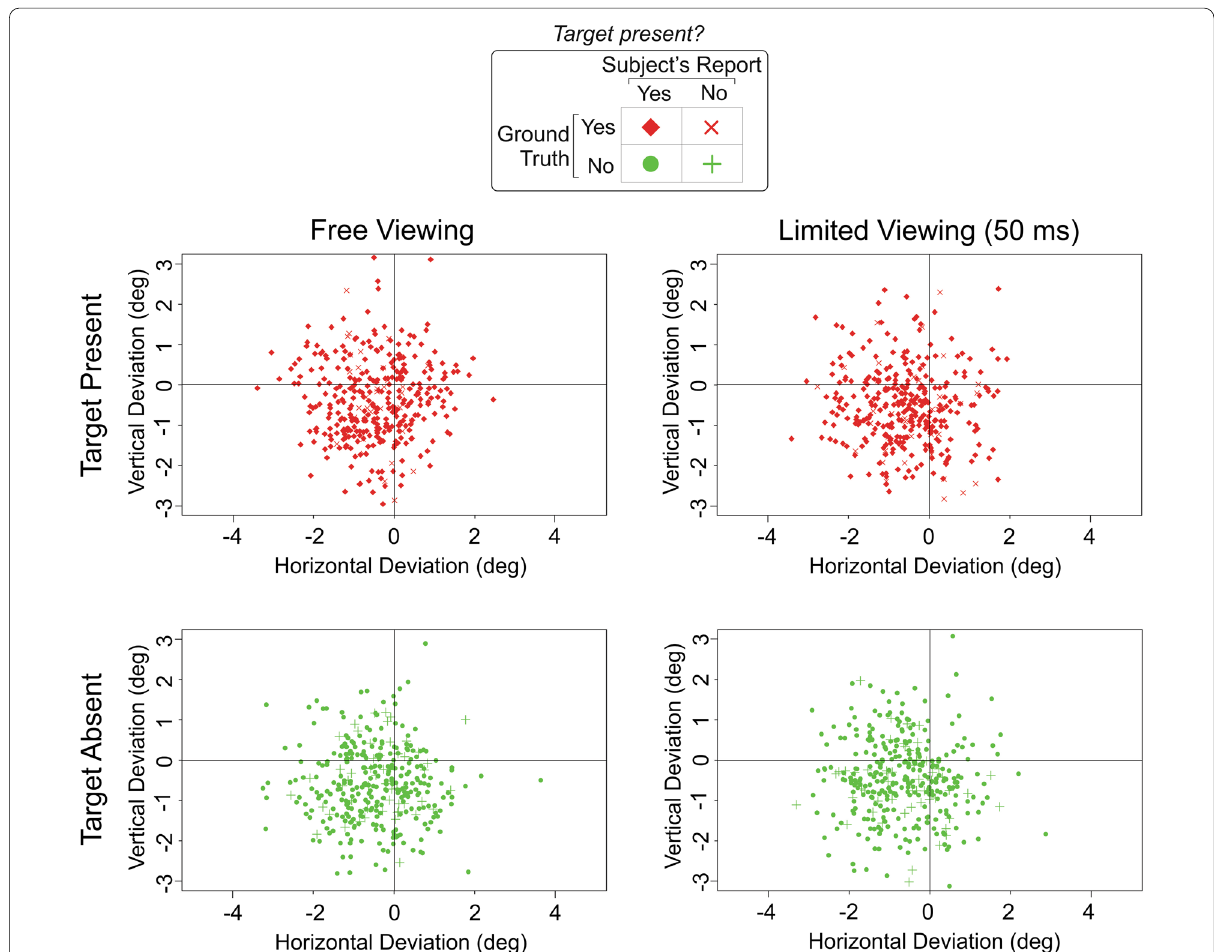
Fig. 2 Localization of camouflage targets in Experiment 1. The scatter plots in the left column show the localization data for free viewing. Scatter plots in the right column show the data for time-limited viewing of 50 ms. Scatterplots in the top and bottom rows show data for stimuli with or without a target, respectively. Scatterplots in the left and right columns show data for stimuli viewed freely or for 50 ms, respectively. Each plotting symbol in each scatterplot denotes the localization data from a single trial (see inset at top center ), plotted as the angular deviation of the reported target location from the actual location, so that the cross-hairs denote perfectly accurate localization. Note that a slight skew of the localization data toward the lower left was visually apparent in each panel. However, this was not statistically significant (not shown). The likeliest cause of this skew is the difference between the perceived center of the target object versus the nominal physical center of the object (not